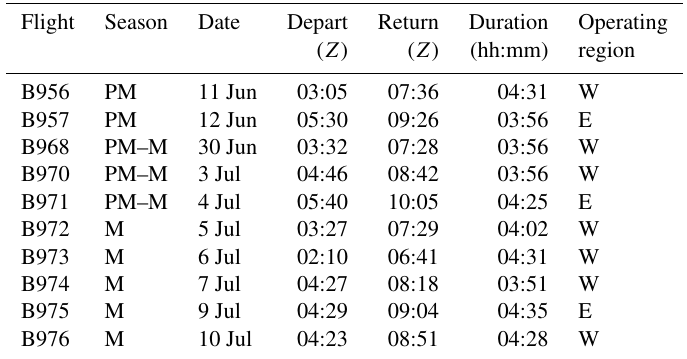
Table 1. Flight summary for operations included in this study. All flights were conducted in northern India in the pre-monsoon (PM) and monsoon (M) seasons (PM–M season refers to transition period of when the monsoon was arriving in northern India). The dates of the flights are shown, with their respective region of study. Flight Season